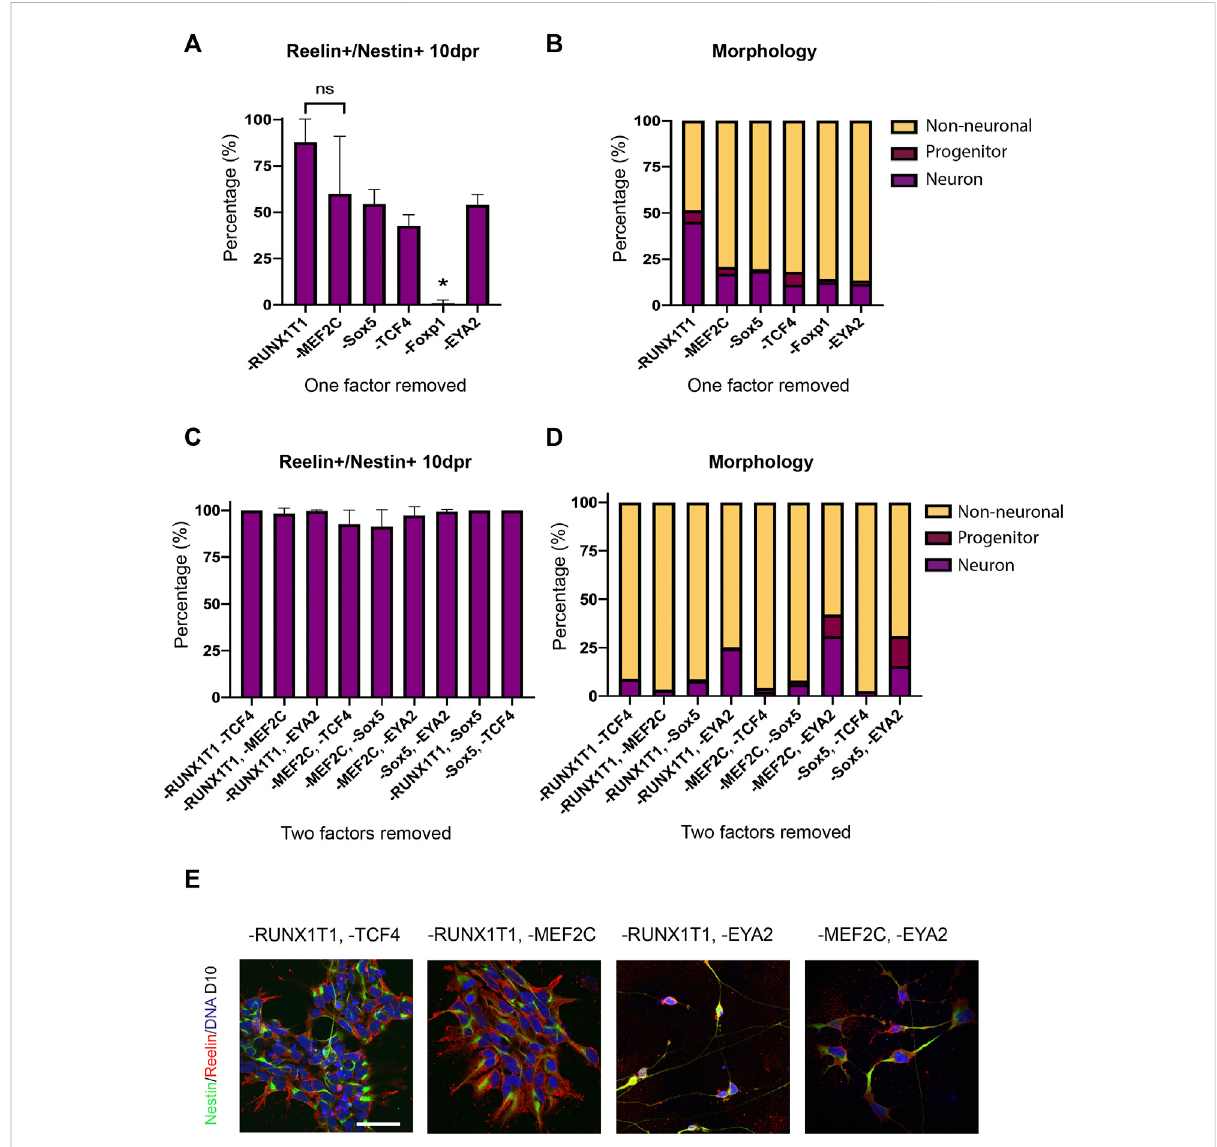
FIGURE 6 Ef fi ciency and morphology of transduced induced pluripotent stem cells (iPSCs) after dropping out a single transcription factor. (A) Co- expression of Reelin and Nestin in cells 10 days post induction (dpi) was signi fi cantly decreased when Foxp1 was dropped out ( p = 0.0013 using a one-way ANOVA) in three human iPSC lines (B) Morphology of transduced cells revealed that removal of RUNX1T1 resulted in a higher number of neurons in the SFC180 iPSC line. (C) Co-expression of Reelin and Nestin in cells 10 dpi with Foxp1 but with drop out of two factors, showed no signi fi cant difference between transcription factor combinations and high conversion rates in the SFC180 iPSC line. (D) Assessment of morphology 10 dpi with Foxp1 but drop out of two factors showed loss of EYA2 resulted in higher numbers of neurons indicating EYA2 is redundant in the reprogramming process. (E) Immunocytochemistry of forward programmed cells 10 dpi shows that dropping out RUNX1T1 in combination with either TCF4 or MEF2C results in cells co-expressing Nestin and Reelin with neural progenitor morphology, whereas dropping out of EYA2